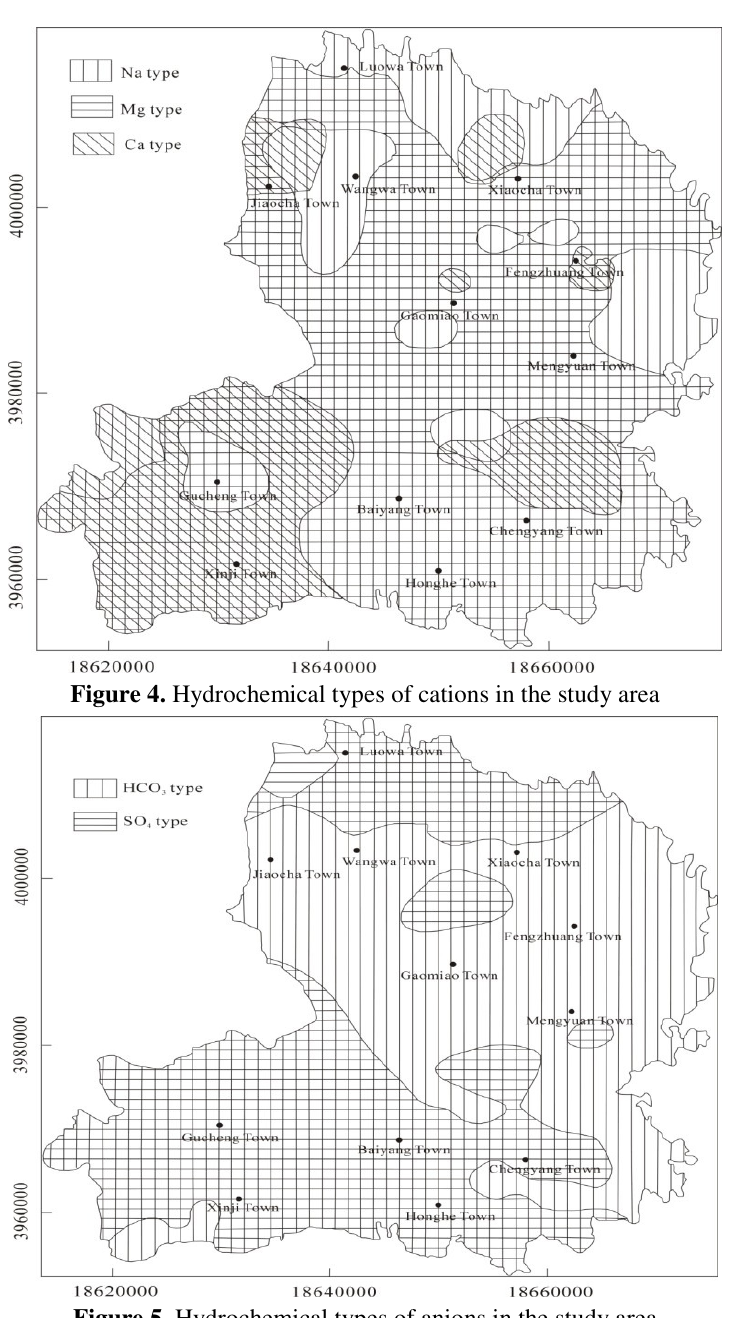
Figure 5. Hydrochemical types of anions in the study